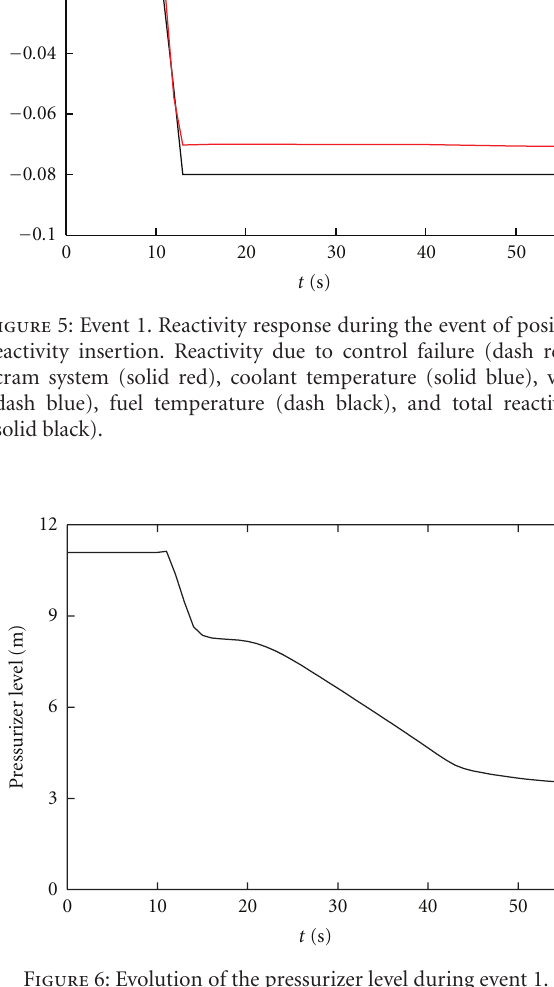
Figure 6: Evolution of the pressurizer level during event 1.